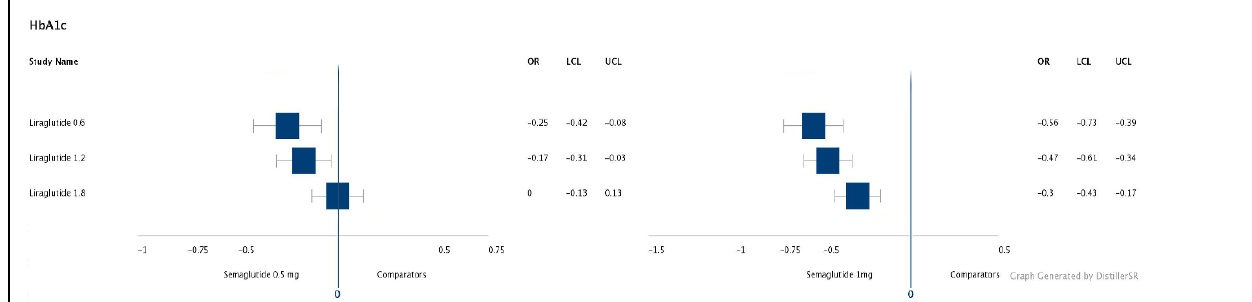
Figure 4. Forest plots of the NMA results: HbA1c outcomes for the primary comparators. The NMA results are presented